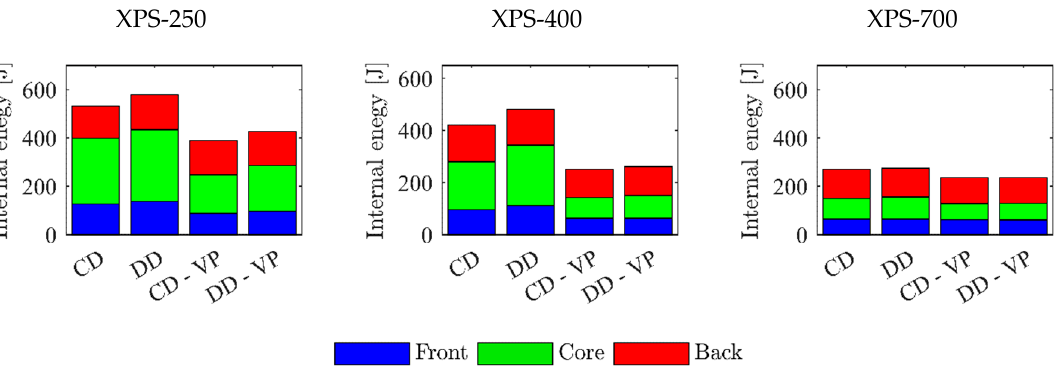
Figure A12. Distribution of internal energy in the numerical models of tests with 15 bar firing pressure.